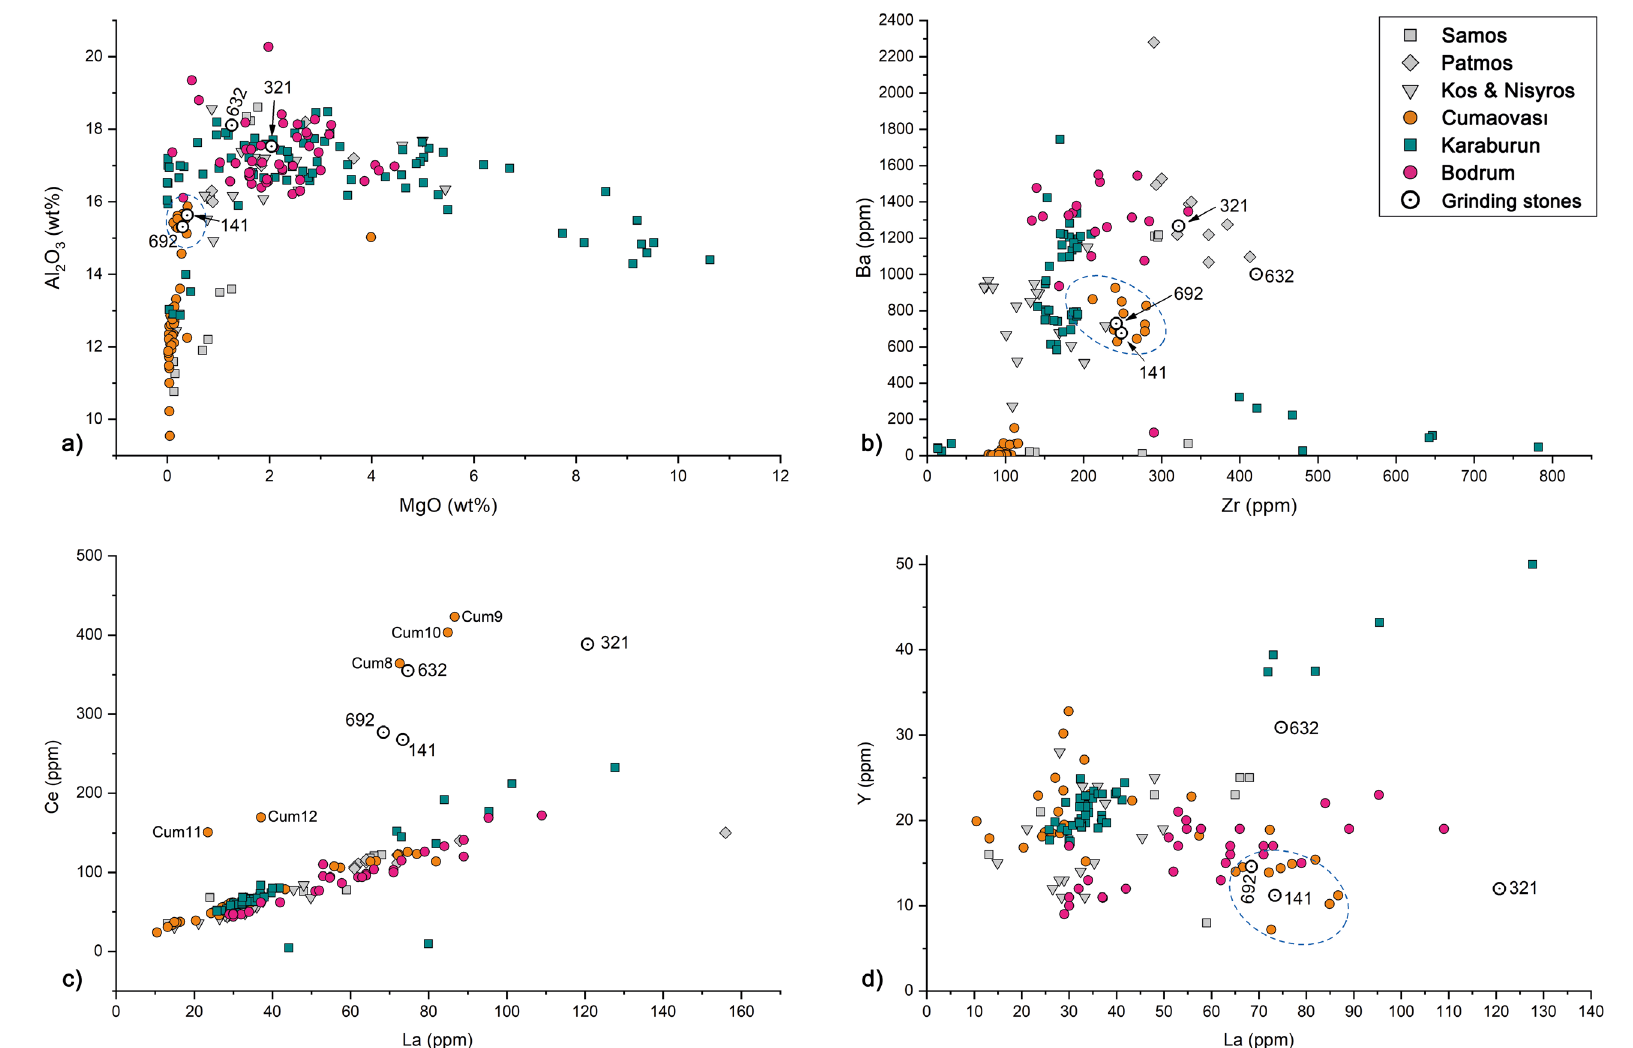
Figure 6. The major- and trace element concentrations (a) Al2O3 and MgO, b) Ba and Zr, c) Ce and La, d) Y and La) of the grinding stones and Cumaovası rocks samples in comparison to the other regions. For references, see Figure 3 (graphic by T.